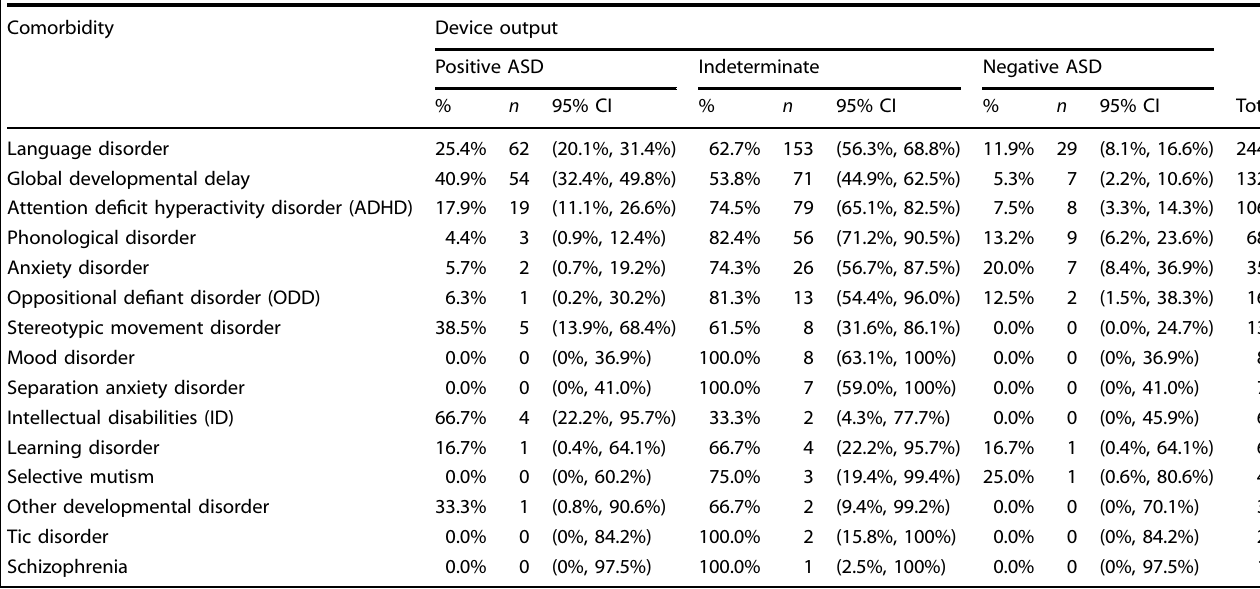
Table 6. Specialist diagnosed comorbidities broken down by device